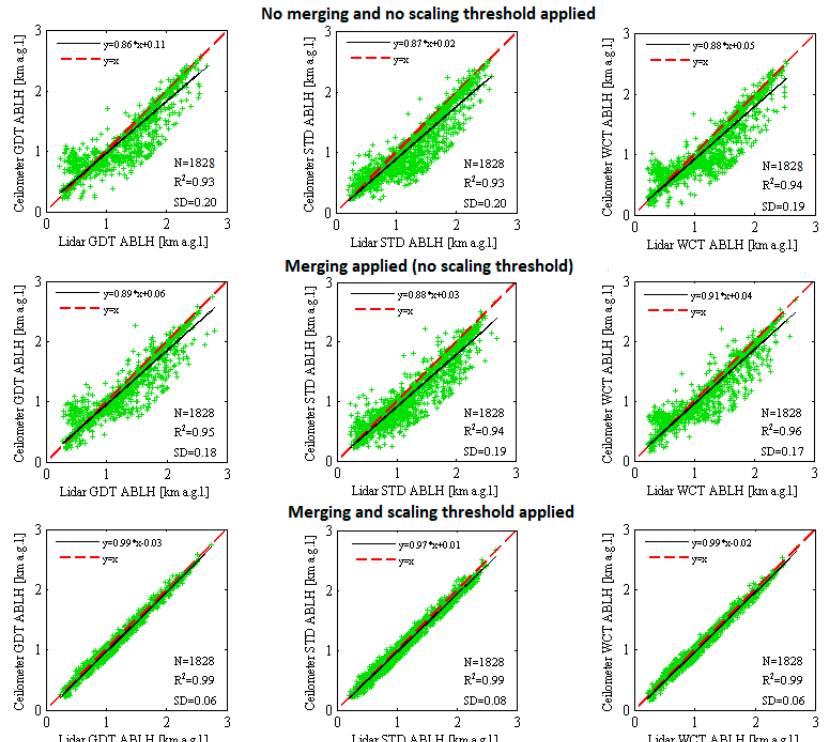
Figure 5. Correlation plots of ABLH obtained from the PollyXT lidar and the CHM15k ceilometer observations in Warsaw derived using the gradient method GDT (left), standard deviation method STD (middle), and wavelet covariance transform WCT (right) algorithms, within the period of July to October 2013 (each data point represents the 10 min average). Top: comparisons for initial resolution datasets; Middle: comparison after lidar-to-ceilometer signal merging (range resolution and height of the first range-bin); Bottom: comparison after lidar-to-ceilometer signal merging and scaling of the lidar ABLHs with the thresholds defined in Equations (1) and